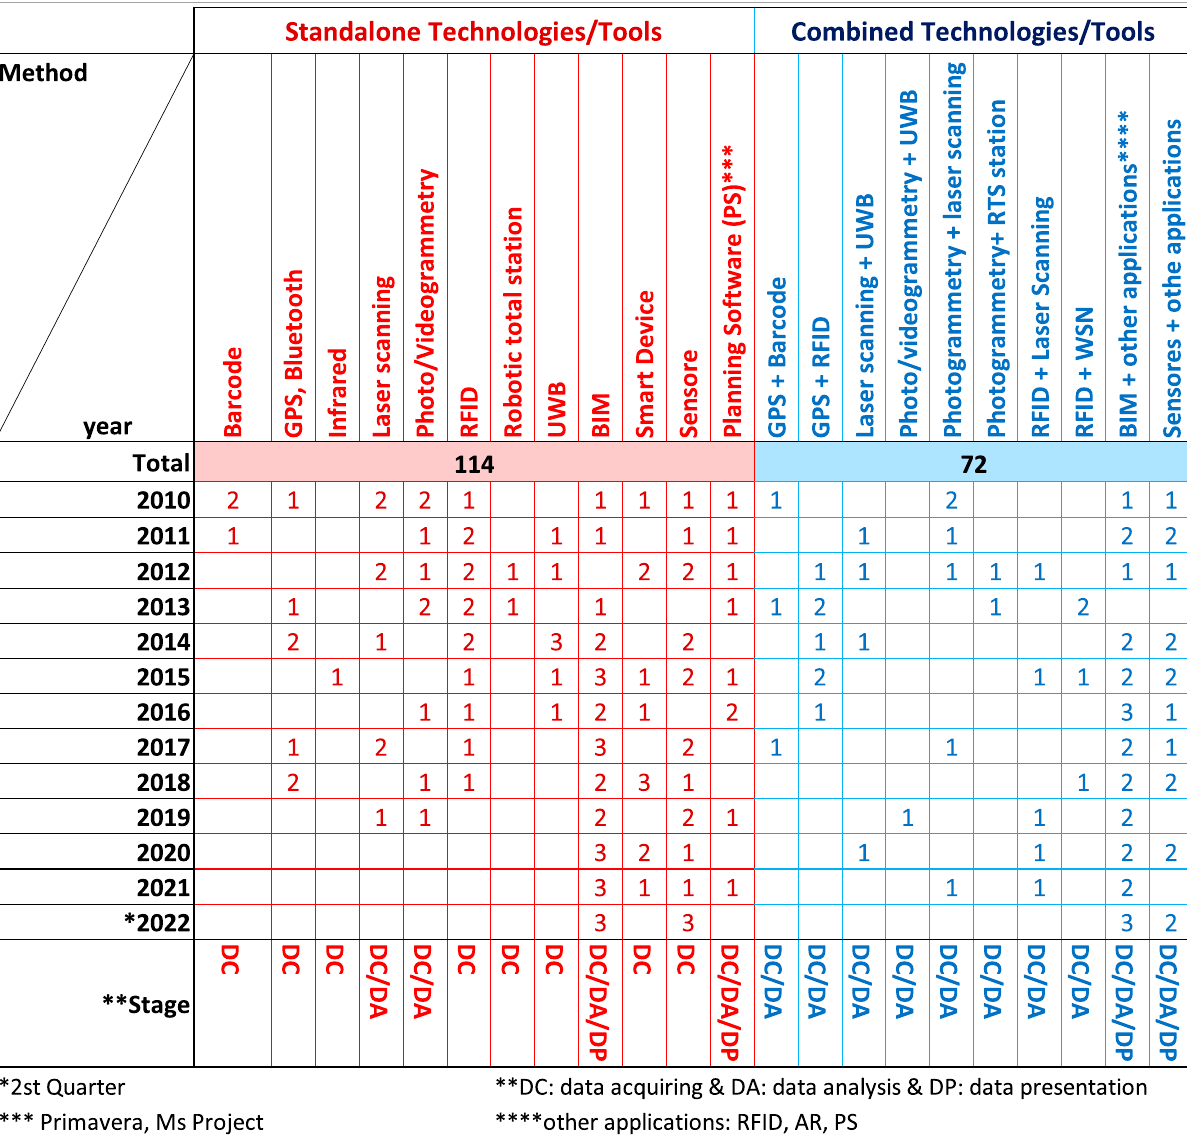
TABLE 3 Publication distribution by research method and